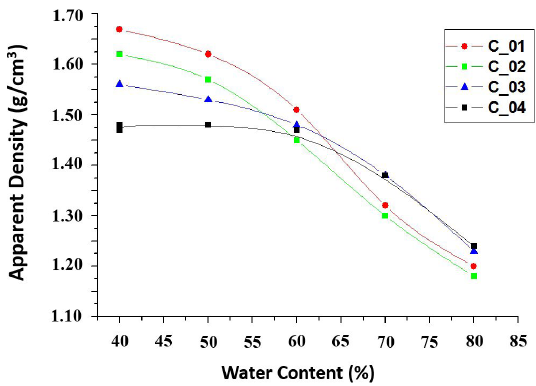
Figure 10. Apparent Density of the magnesium phosphate cements prepared from MgO powders calcined at 900 °C / 2 h and with different MgO/NH H PO ratios, by mass. 4 2 4